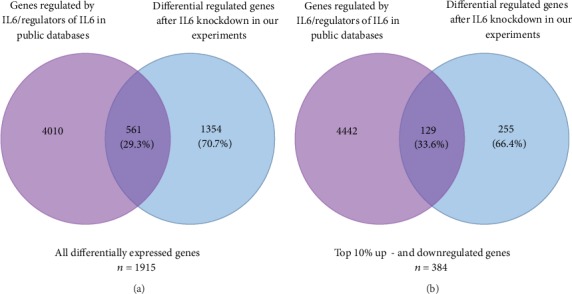
Knockdown of IL6 in human endothelial cells lead to identification of a large number of novel IL6-regulated genes. Comparison of lists of genes differentially regulated after IL6 knockdown in human endothelial cells with lists of known interaction partners of IL6 found in public databases (the Ingenuity Knowledge Base® (IPA) and the STRING database). Numbers in intercepts stand for known interaction partners of IL6 found in either IPA or in STRING and differentially regulated by IL6 knockdown in human endothelial cells in our experiments. Numbers outside intersections represent known interaction partners for IL6 found in IPA or STRING but not differentially regulated after IL6 knockdown (in purple) and differentially regulated genes after IL6 knockdown not described as interaction partners in IPA or STRING (in blue). (a) All differentially regulated genes after IL6 knockdown (n = 1915). (b) The top 10% most up- or downregulated genes after IL6 knockdown.